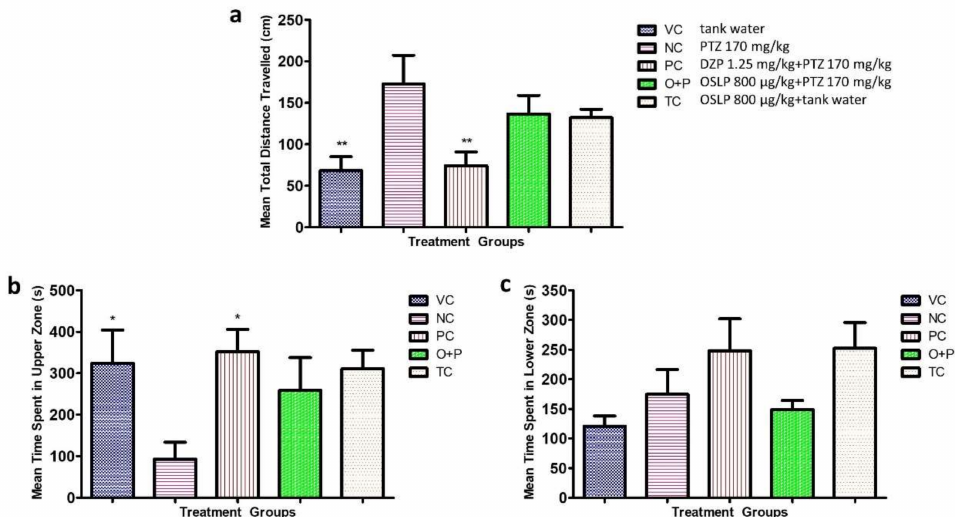
Figure 6. Mean locomotion parameters over 600 s for all the experimental groups. Figure ( a ) represents the mean total distance travelled (cm), Figure ( b ) shows the mean time spent in upper zone (s) and Figure ( c ) displays the mean time spent in lower zone (s). The data are expressed as Mean ± SEM, n = 10 and was analyzed using One-way ANOVA followed with Dunnett’s post-hoc test at significance level of * p < 0.05 and ** p < 0.01 against the negative control group (NC, PTZ 170 mg / kg). VC (tank water, i.p.), PC (DZP 1.25 mg / kg + PTZ 170 mg / kg, i.p.), O + P (OSLP 800 µ g / kg + PTZ 170 mg / kg, i.p.) and TC (OSLP 800 µ g / kg + tank water,